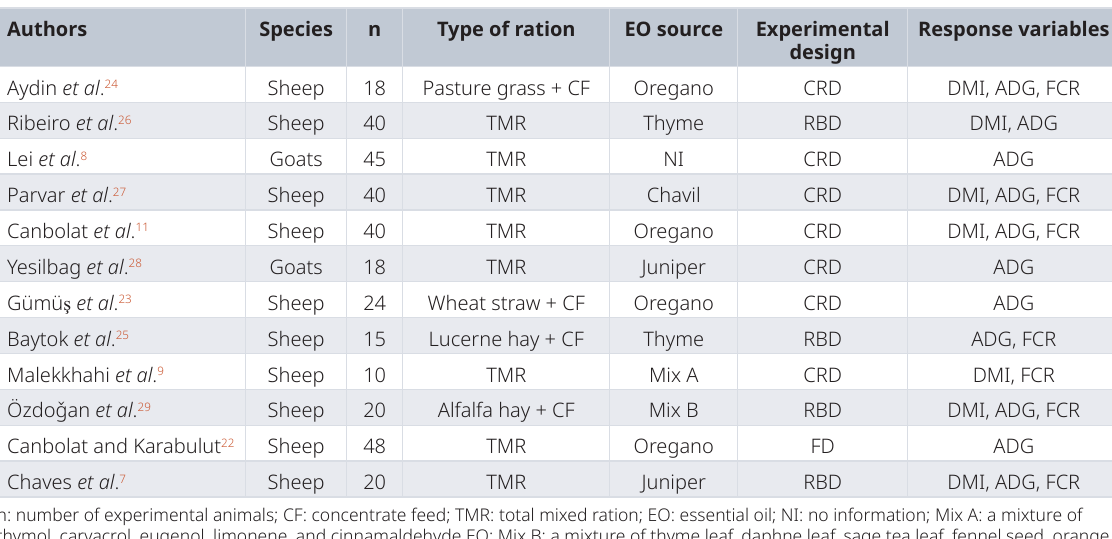
Table 3. Main characteristics of the studies included in the meta-analysis.